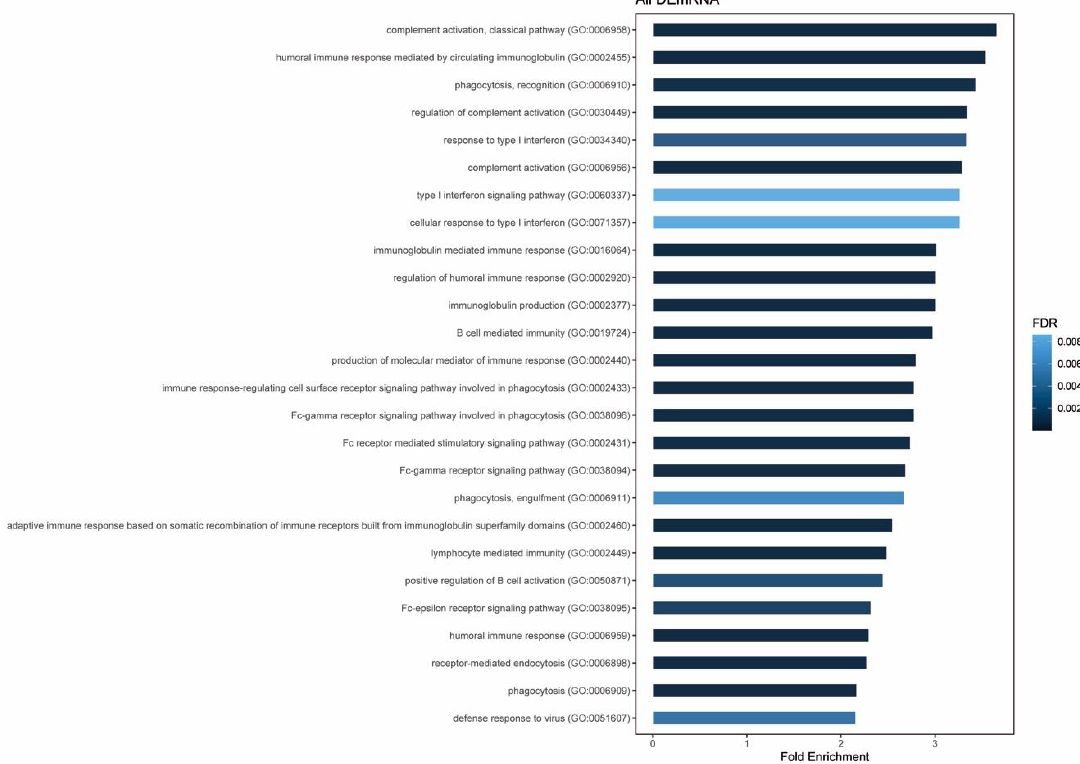
Table 2. ROC analysis results of the four candidate transcripts and different combinations. ROC— receiver operating characteristic